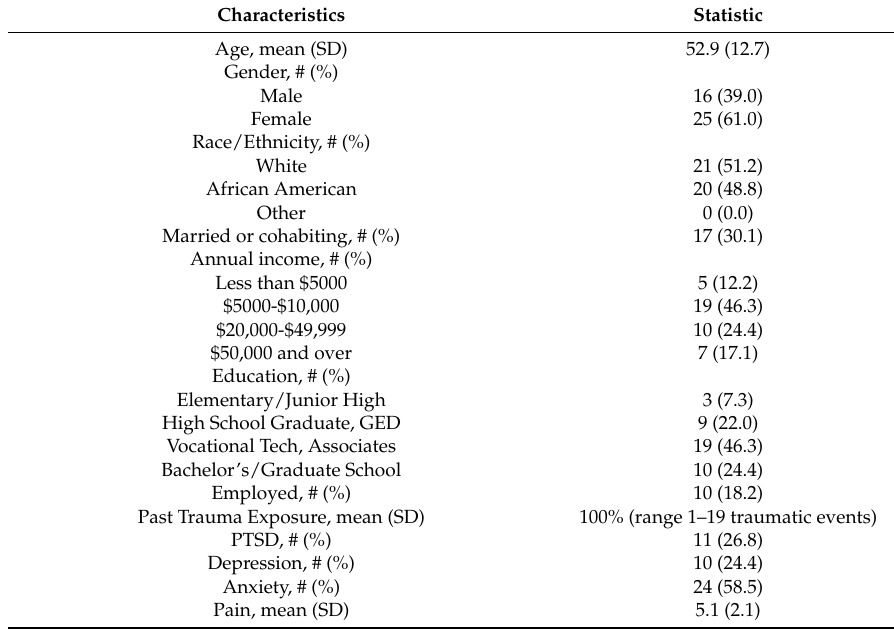
Table 1. Characteristics of the sample.